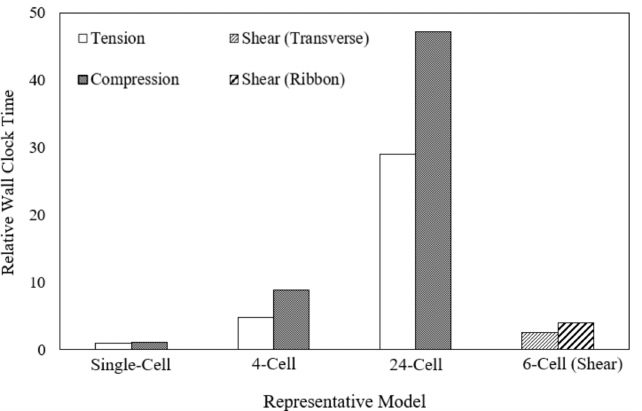
Figure 21. Comparison of relative wall-clock time taken by the different cell models FE models for the out-of-plane load